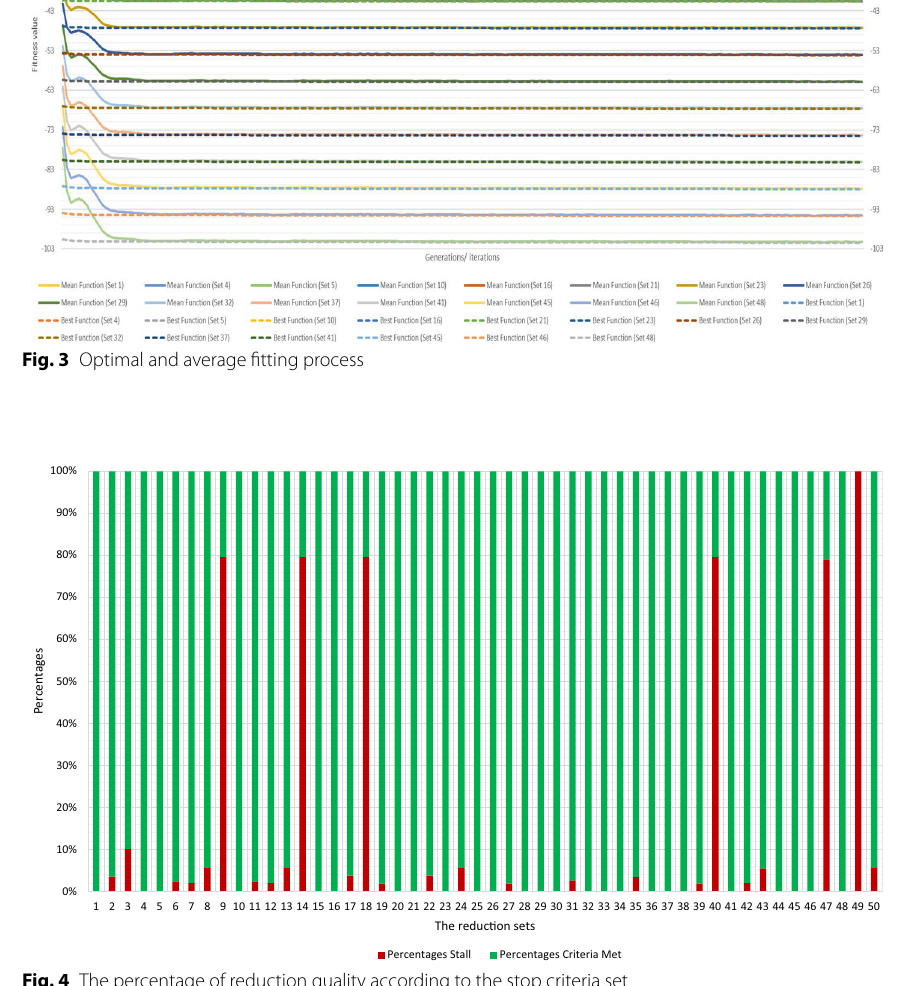
Fig. 4 The percentage of reduction quality according to the stop criteria